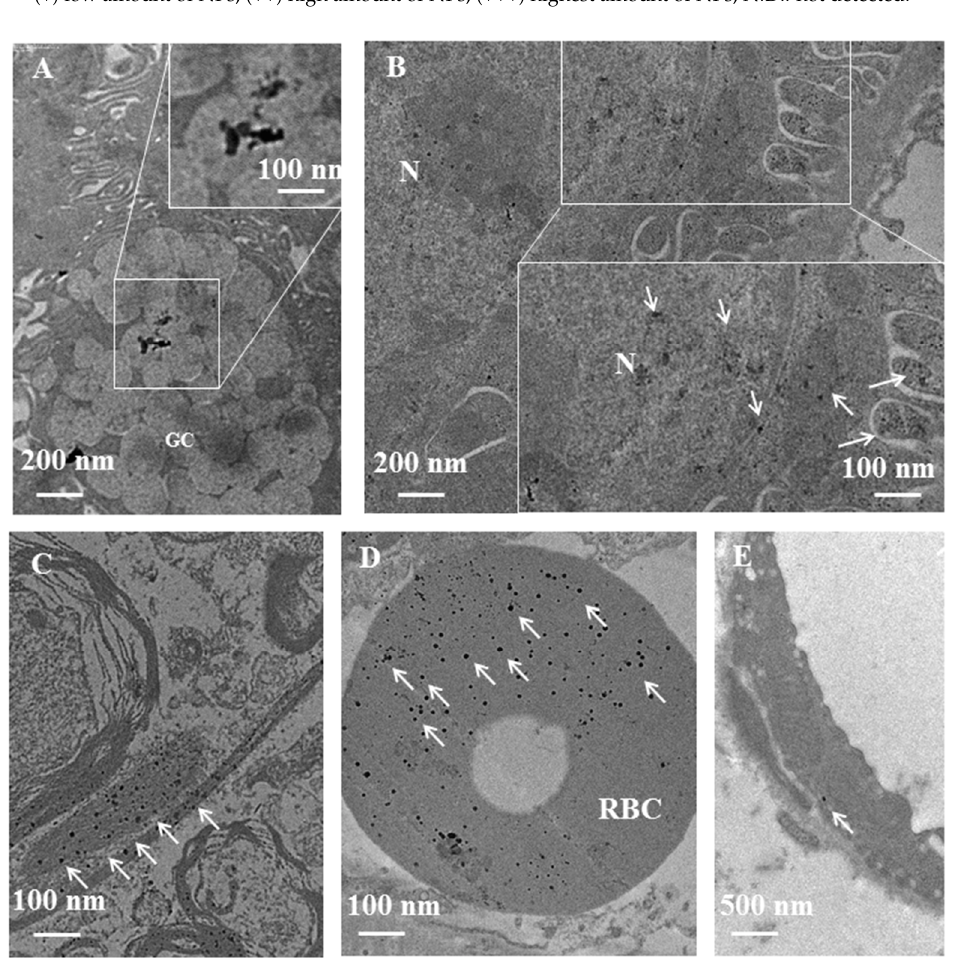
Figure 3. Biodistribution of AuNPs in a murine model after injection of 108 NPs in tail vein. Scanning transmission electron microscopy (STEM) micrographs of ultrathin sections of mouse organs. White arrows indicate AgNPs as single NPs or as cluster. N: nucleus; M: mitochondria. ( A , B ) liver (dark field); ( C , D ) heart; ( E , F ) brain (dark field ( E ), bright field ( F )); ( G ) kidney (bright field); ( H ) macrophage in the connective tissue in intestinal villi.